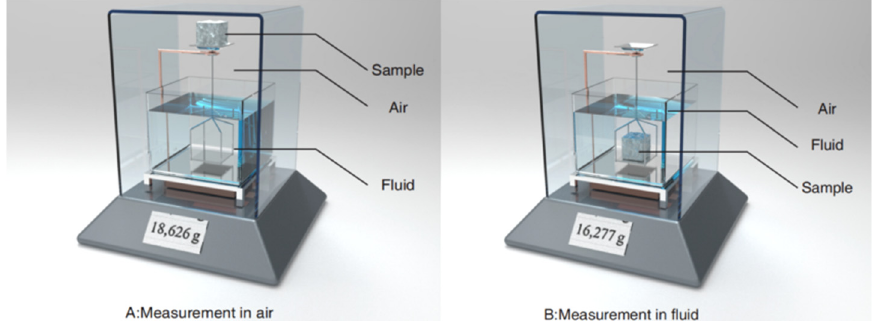
Figure 2. Measurement in air and liquid.